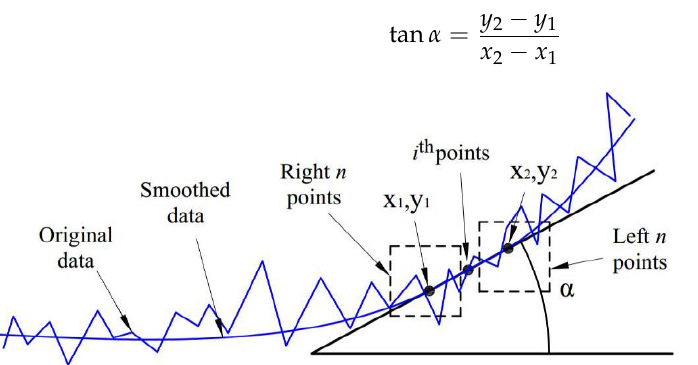
Figure 4. Determination of slope in smoothing technique.